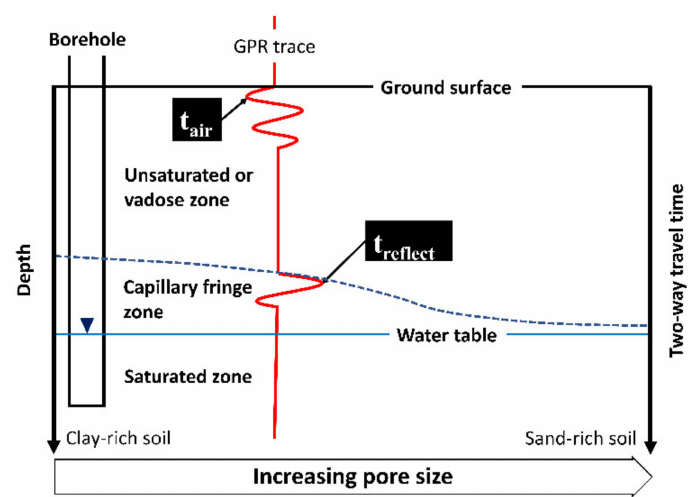
Figure 1. Schematic diagram showing the uncertainty of the water table depth (WTD) estimation using ground penetrating radar (GPR) due to e ff ect of capillary rise under variable pore sizes (modified from Paz et al.